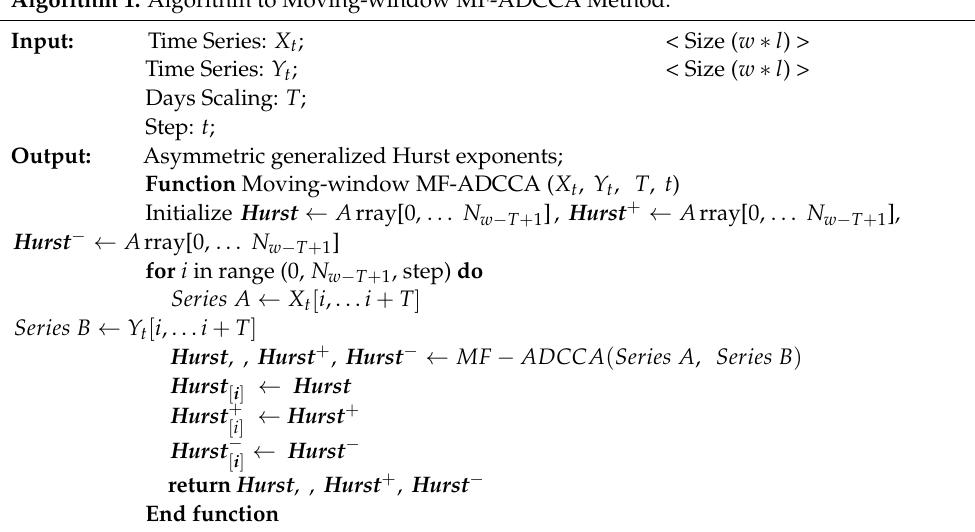
Algorithm 1. Algorithm to Moving-window MF-ADCCA